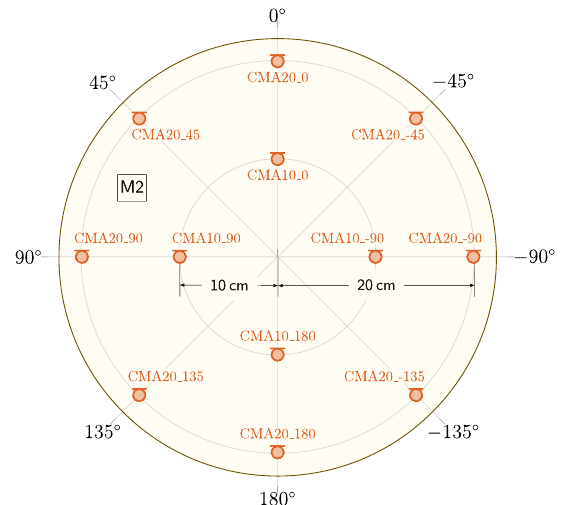
Fig. 4 Plan view of the M2 microphone configuration. A description of the microphone labels is given in Table 2. The radial grid spacing of the polar plot is 0.1 m. DPA 4060 microphones are used for the inner circular microphone array and AKG CK32 microphones are used for the outer circular microphone array. The circle drawn around the microphones represents the M2 microphone configuration in the floor plans in Fig. 6. For extracting more precise coordinates of the microphone and loudspeaker positions, the MATLAB or Python scripts discussed in Section 6.2 should be used